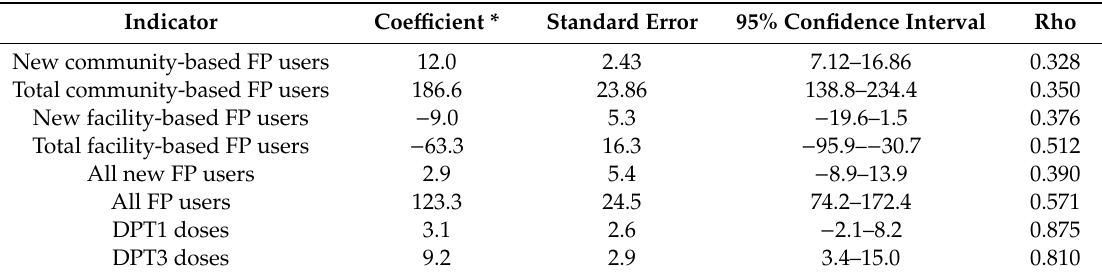
Table 2. E ff ect of intervention on use of family planning and immunization services; Dowa